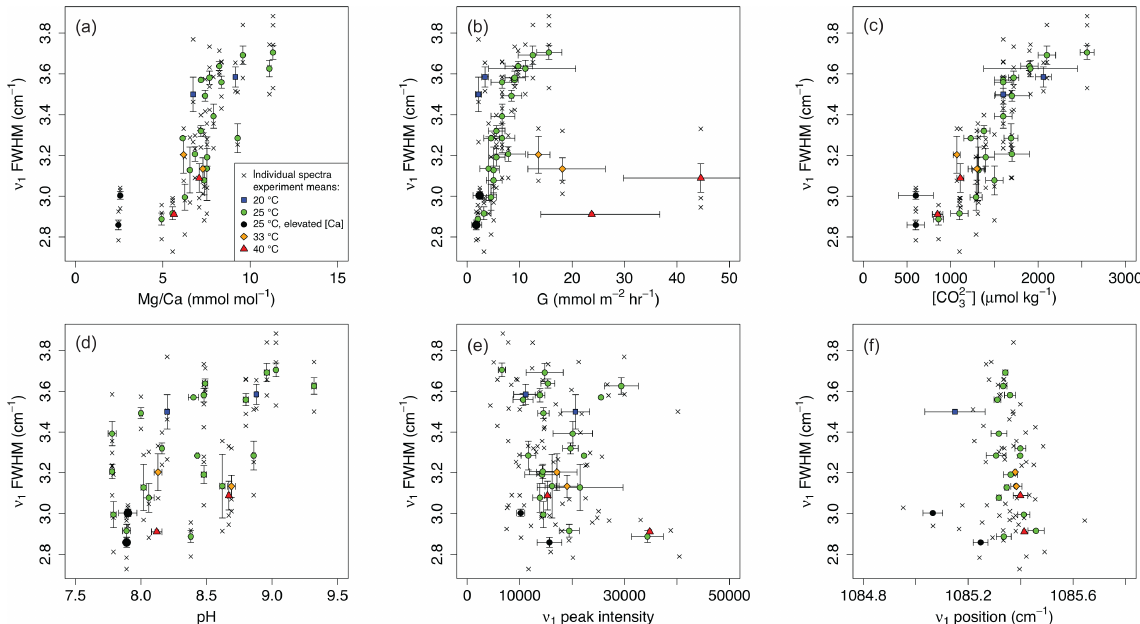
Figure 3. Scatter plots of Raman true peak width ( ν 1 FWHM) and (a) aragonite Mg / Ca, (b) aragonite precipitation rate, (c) experimental fluid [CO 2 − ], (d) experimental fluid pH, (e) Raman peak intensity, and (f) Raman peak position. Colours indicate experiments conducted 3 at various temperatures, and black circles indicate the two experiments conducted with elevated [Ca 2 + ]. While some apparent correlations exist, statistical models (Table 1) imply that (cid:127) Ar is the variable controlling ν 1 FWHM, and that the patterns observed here may be artefacts of correlations between these factors and (cid:127) Ar .